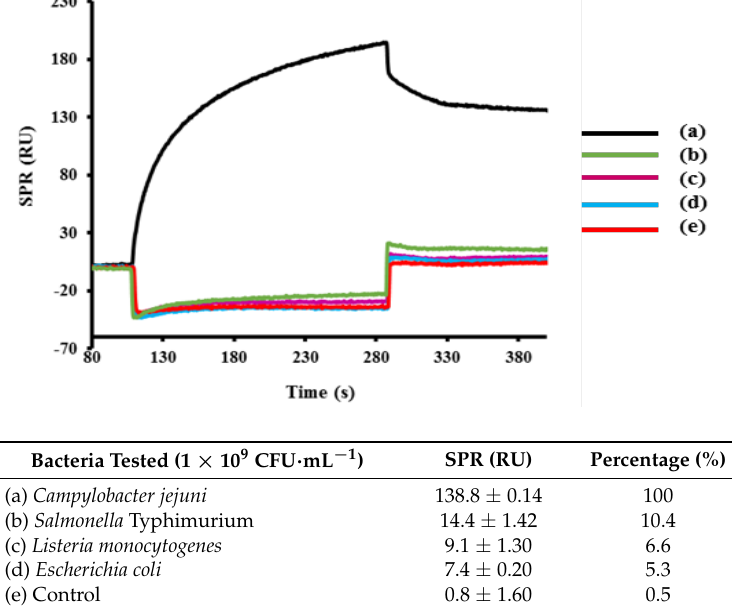
Figure 5. The SPR sensorgram of cross-reactivity analysis showing the binding response of C. jejuni compared with other foodborne bacteria ( E. coli, L. monocytogenes, S. Typhimurium) and also negative control (PBS) using the sandwich assay format. The concentration of all bacteria was fixed at 1 × 10 9 CFU·mL −1 and the percentage of the cross-reactivity is shown below. The surface was immobilized with C. jejuni specific antibody.